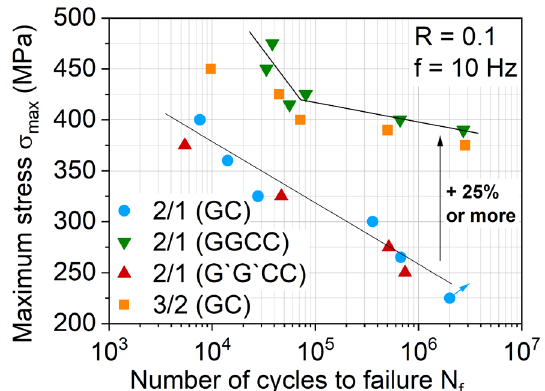
Figure 13. S-N relationship for hybrid laminates with different layer structures and metal volume